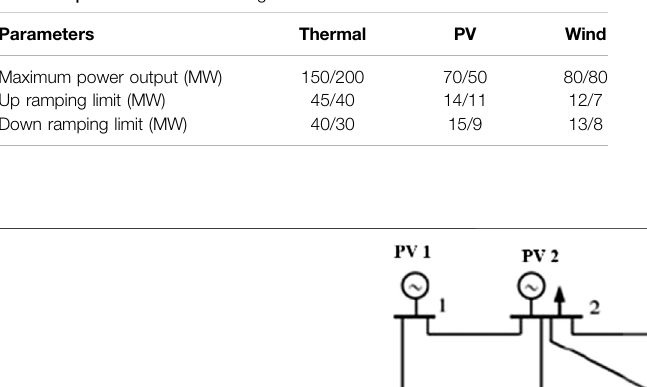
TABLE 1 | Parameters of thermal generators and renewables. TABLE 2 | Parameters of storage and EV.